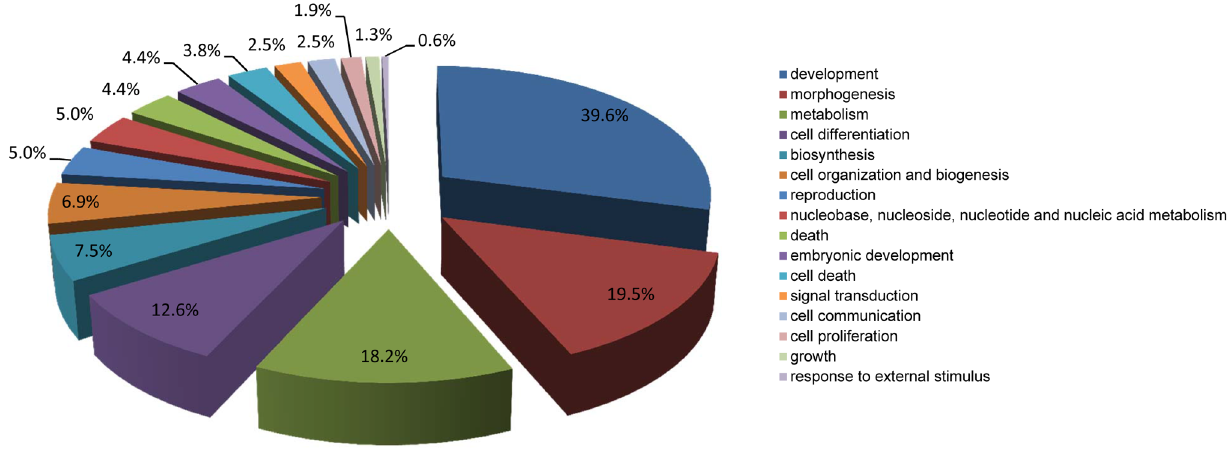
Figure 6. Distribution of enriched GO terms according to GO slim for the 96 DEGs identified throughout ESC differentiation. The percentage indicates the number of GO terms in each class as a percentage of the total number of unique GO terms (159) enriched by the